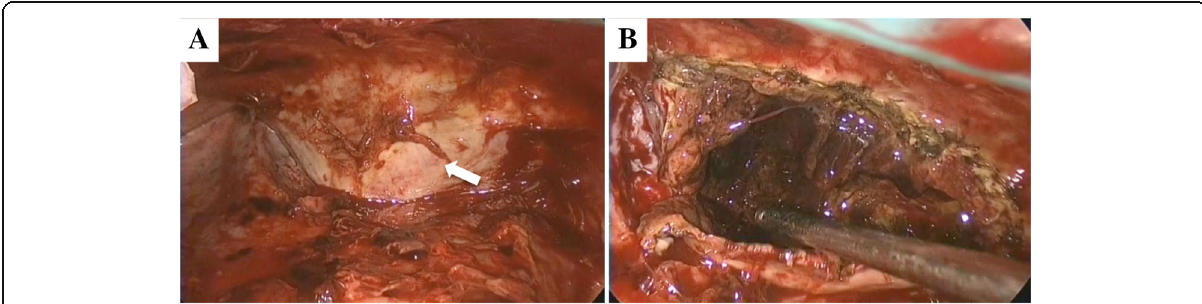
Fig. 4 Intraoperative findings of a pleural bulge in the posterior chest wall due to the extrapleural hematoma (white arrow) ( a ) and dissection of the thick dorsal parietal pleura to resect a large amount of hematoma ( b